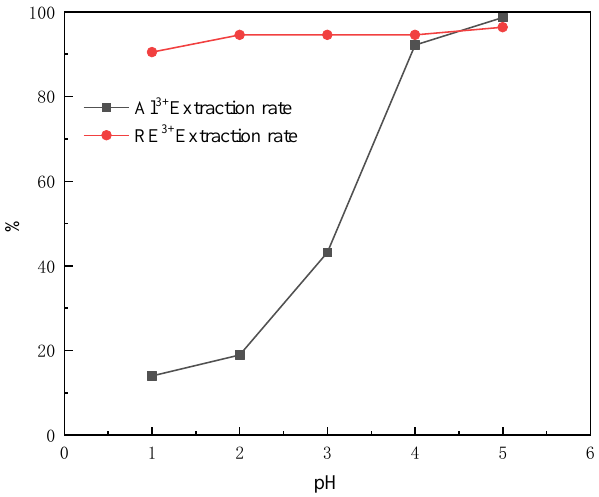
Figure 3. Effect of pH on separation of rare earths and aluminum.